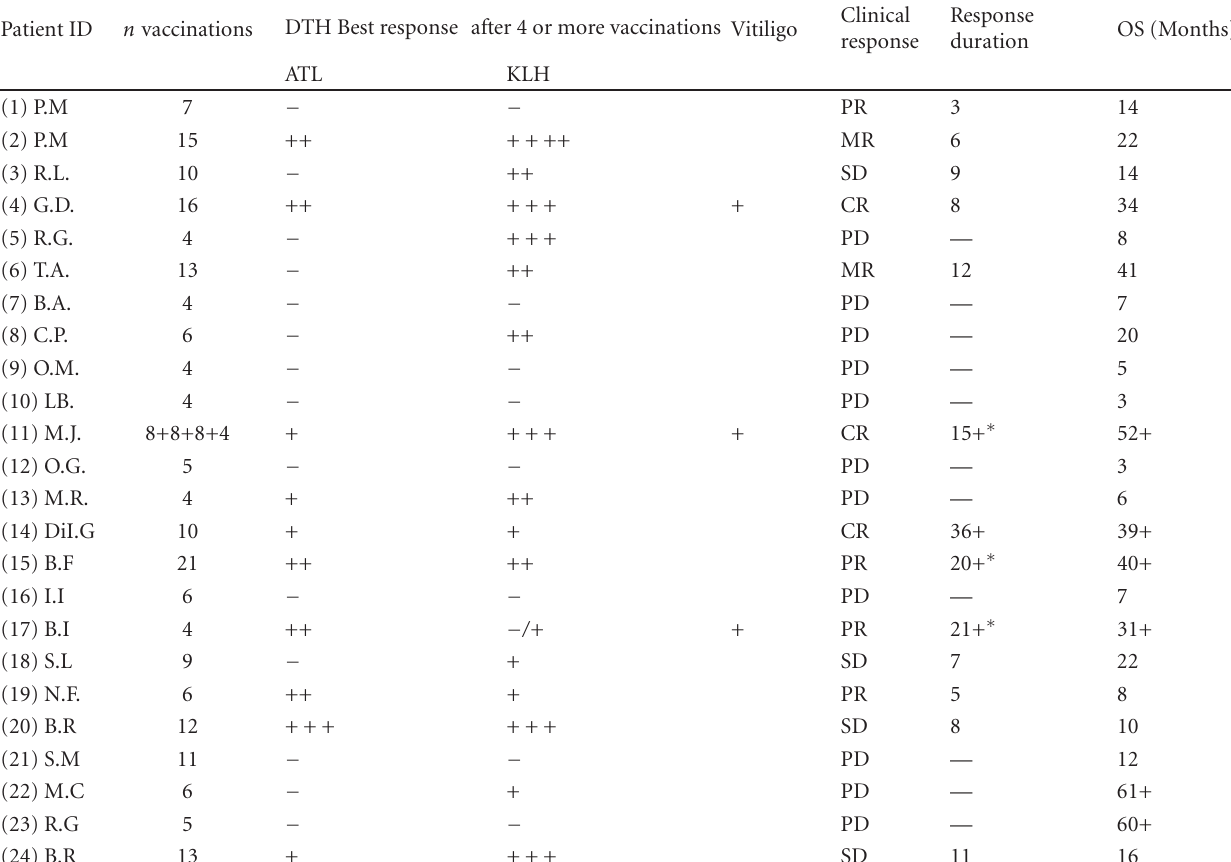
Table 3: Update (June 2009) of results on 24 patients treated with mDC